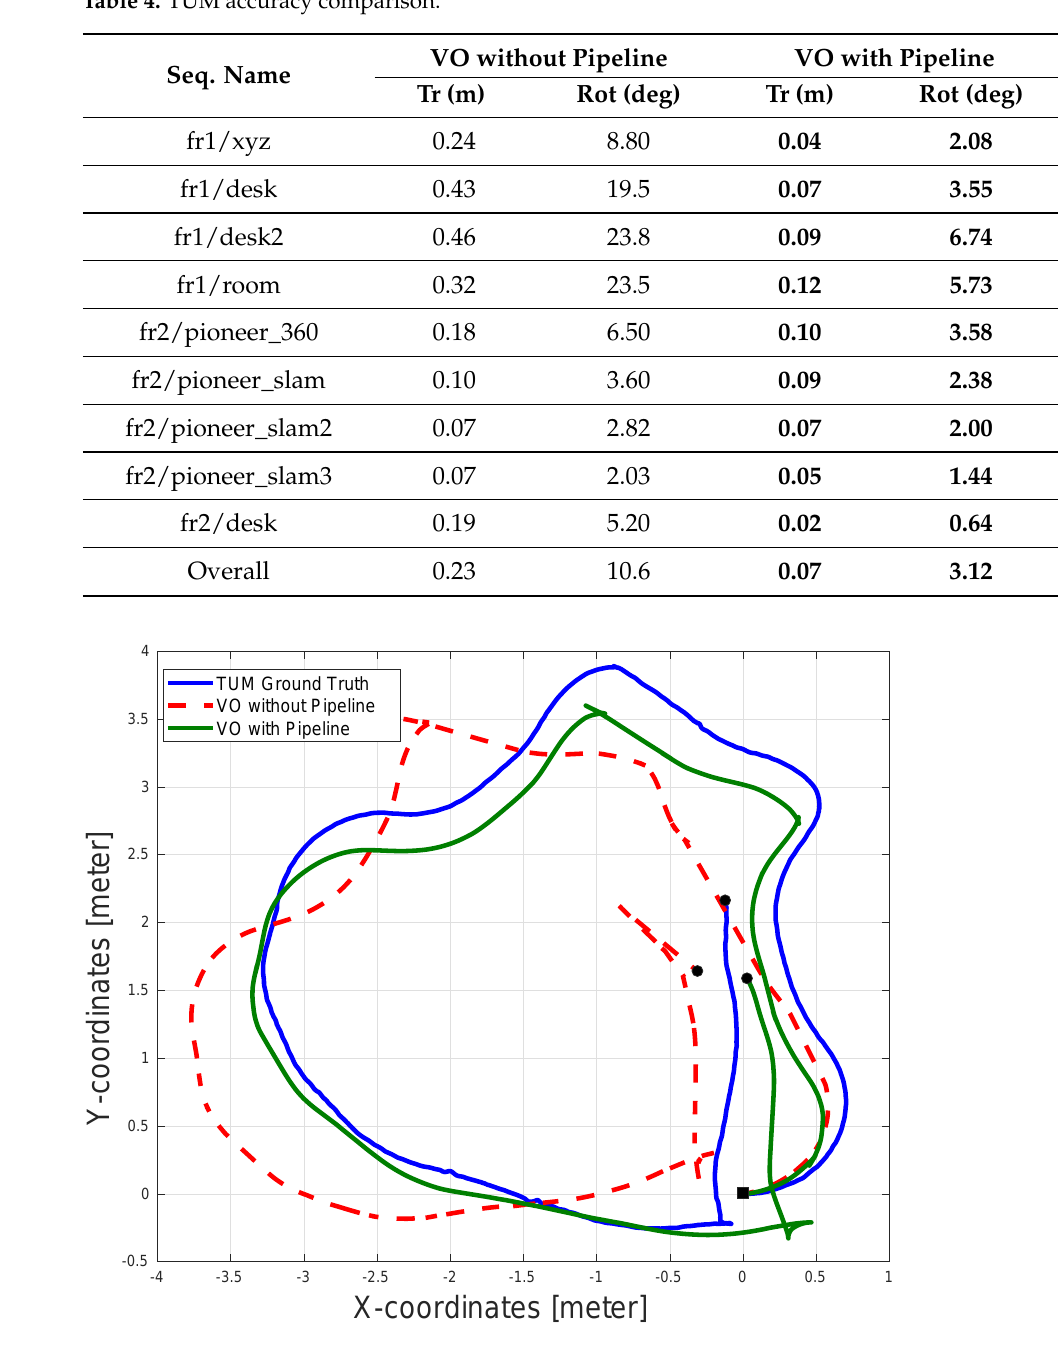
Table 4. TUM accuracy comparison.